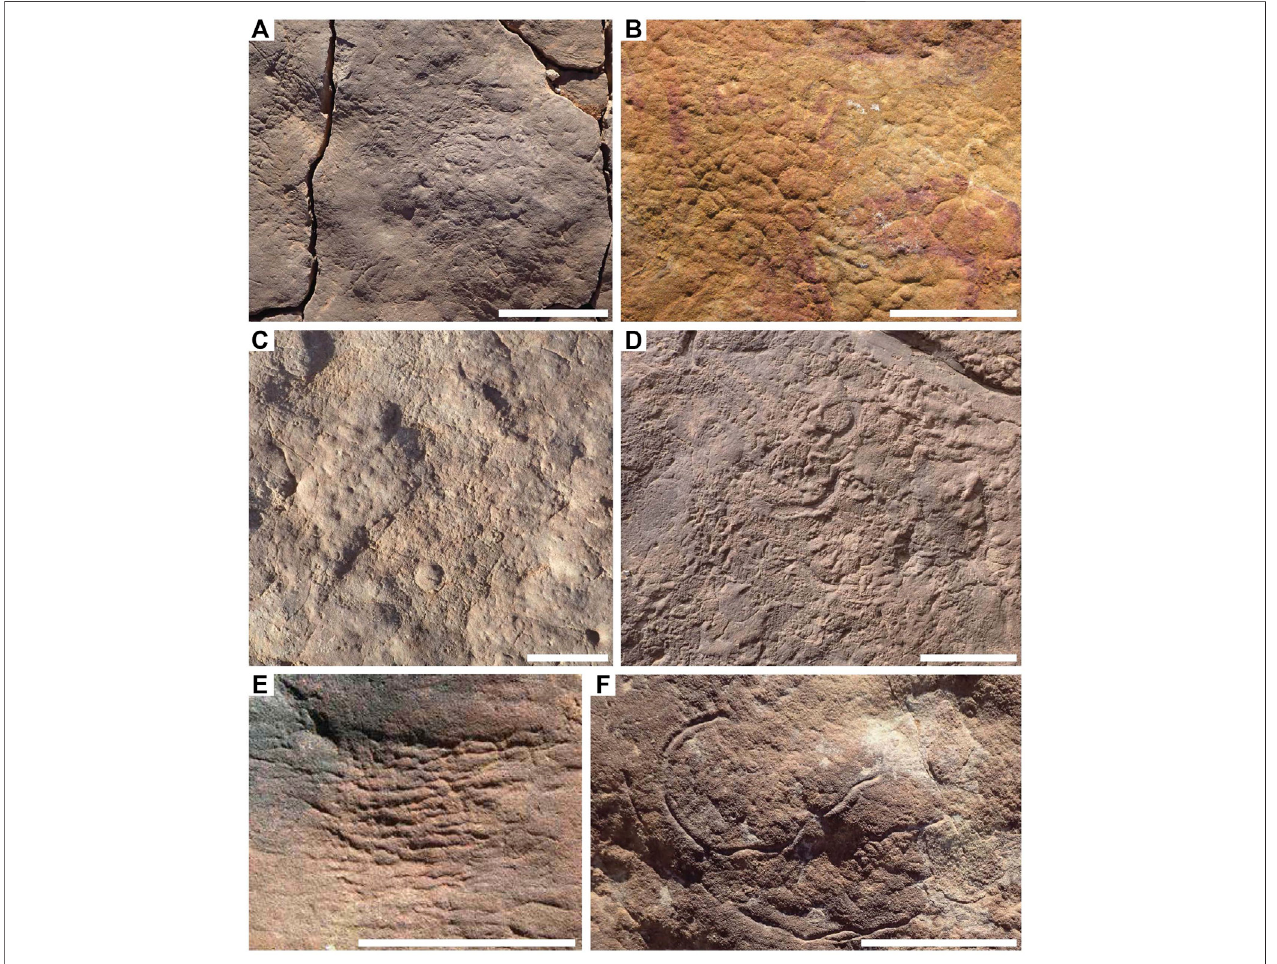
FIGURE1| Texturedorganicsurfaces(TOS)onexcavatedbedsfromtheEdiacaraMemberandtheinformalNilpenaMember. (A) TOSonbeddingplaneTB-ARB. (B) Elephant skin TOS. (C) TOS on bedding plane 1T-F-Annex. (D) TOS on bedding plane WS-Sub. (E) Weave on TC-MM3 bedding plane. (F) Helminthoidichnites preserved in hyporelief on the bedding plane of TB-Sh2. Scale bars = 5 cm.